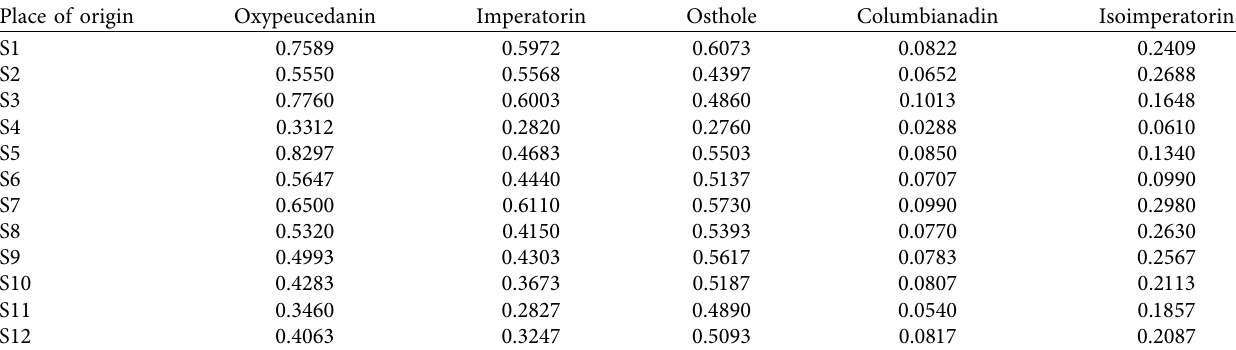
Table 3: Determination of results of APR in different origins (%).